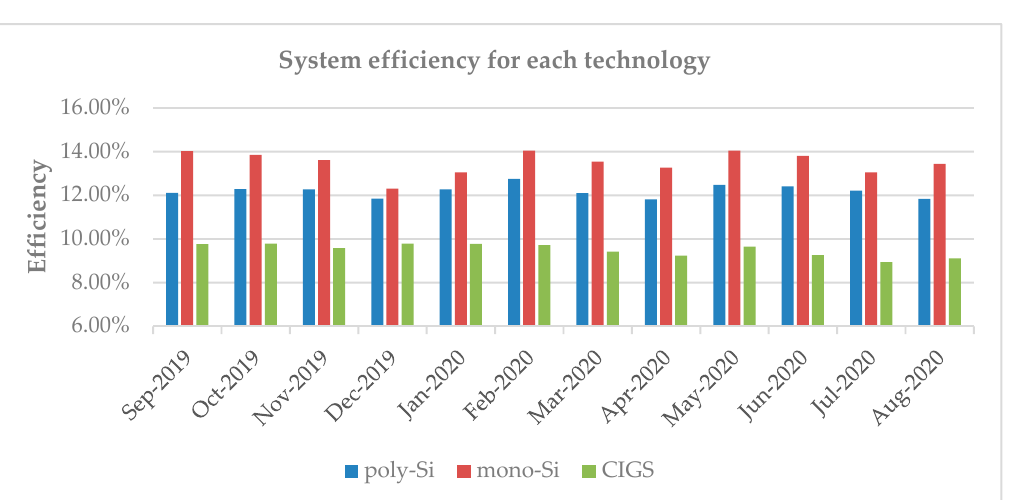
Figure 10. System efficiency for each technology.